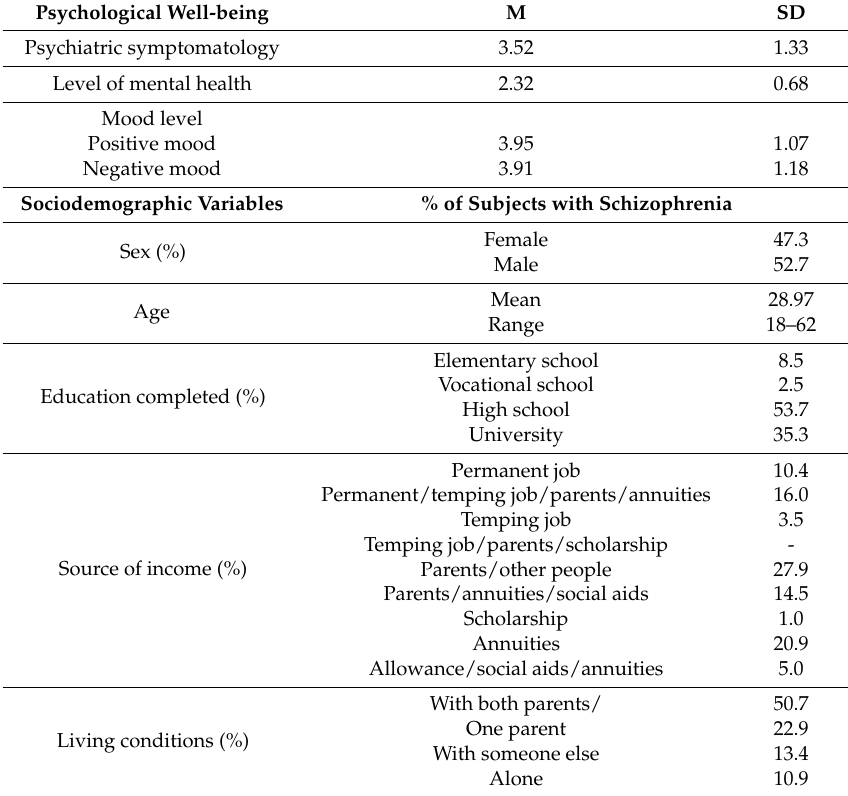
Table 1. Indices of components of the sociodemographic variables and explained variable of patients suffering from schizophrenia ( N =